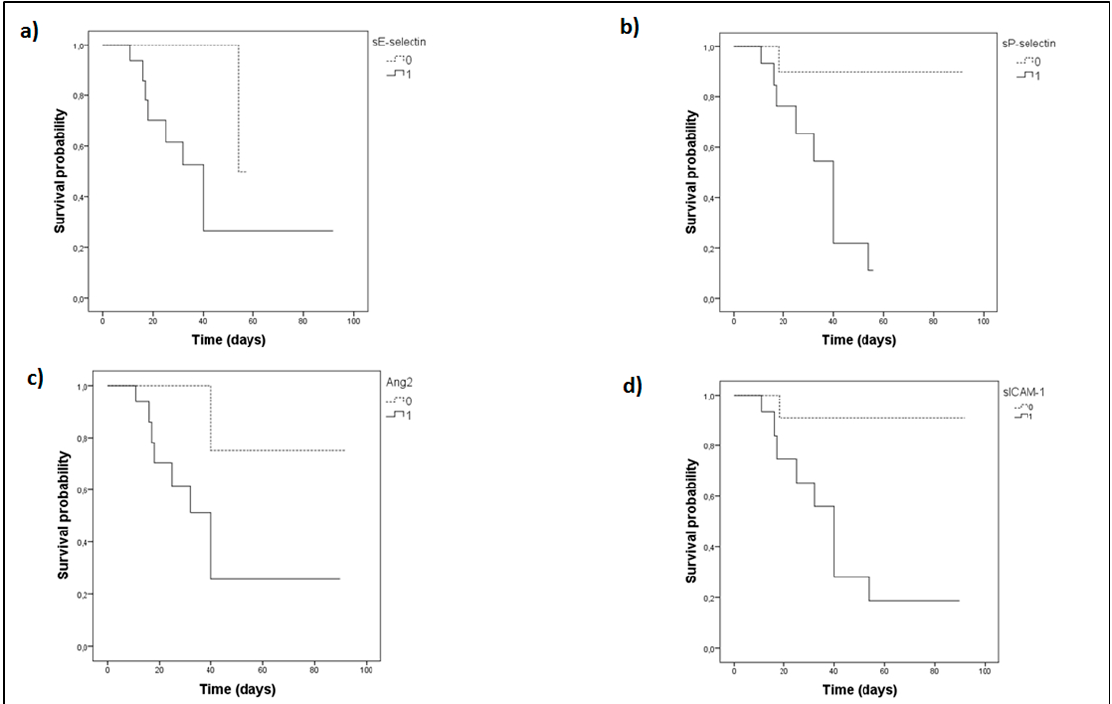
Figure 3. Biomarker levels on admission and intensive care unit (ICU) survival probability. ( a ) sE-selectin, ( b ) sP-selectin, ( c ) Ang-2, ( d ) sICAM-1. sE-selectin, sP-selectin, Ang-2, and sICAM-1 were measured upon ICU admission (within 24-h). The Kaplan–Meier method was used for ICU survival probability estimation and the log-rank test for two-group comparison. The ICU patient cohort was dichotomized above and below the respective median value of each biomarker. Solid lines: ≥ median value (high group); dashed lines: <median value (low group). The respective median time to mortality for the two aforementioned groups were as follows: ( a ) sE-selectin, 44 days (95% CI: 28–61) for the high group, and 56 days (95% CI: 53–58) for the low group (Log-Rank test, p = 0.038); ( b ) sP-selectin, 35 days (95% CI: 26–43) for the high group, and 85 days (95% CI: 71–98) for the low group (Log-Rank test, p = 0.009); ( c ) Ang-2, 43 days (95% CI: 26–61) for the high group, and 79 days (95% CI: 57–101) for the low group (Log-Rank test, p = 0.048); ( d ) sICAM-1, 42 days (95% CI: 27–57) for the high group, and 85 days (95% CI: 73–98) for the low group (Log-Rank test, p = 0.022). Ang-2 = Angiopoietin-2; s = soluble; sICAM-1 = soluble Intercellular adhesion molecule 1.